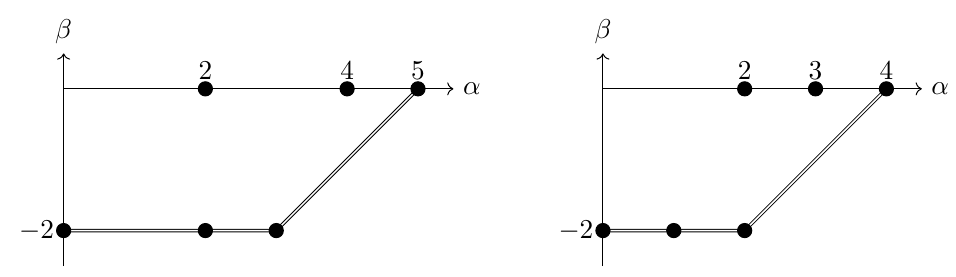
Figure 5 . The left picture is the Newton diagram of equation (4.48), and the right picture corresponds to (4.52). Note the both diagrams show a possible linear backreaction behavior in addition to the bad constant backreaction